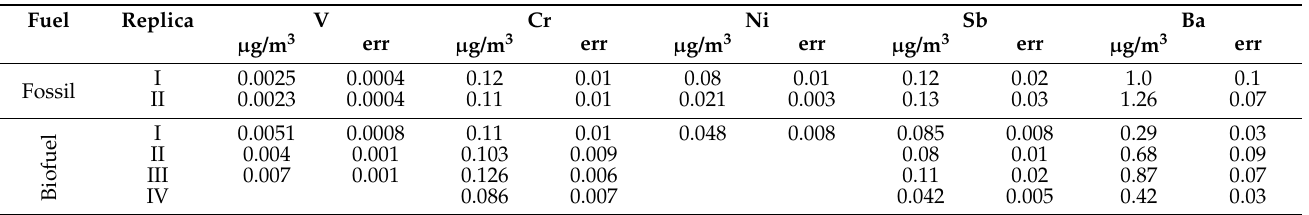
Table A7. Concentration of metals during the different tests. Data are reported as average and the relative error.